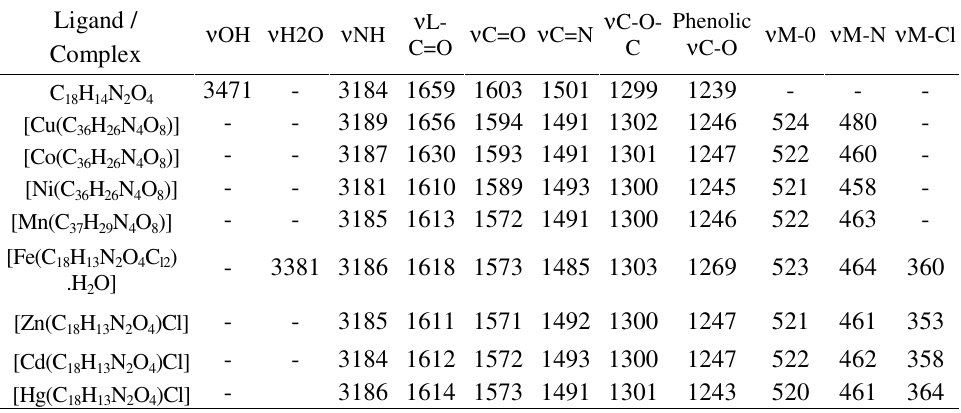
Table 3. Important spectral IR bands of the ligand [HL] and its metal complexes (cm -1 ). Ligand /